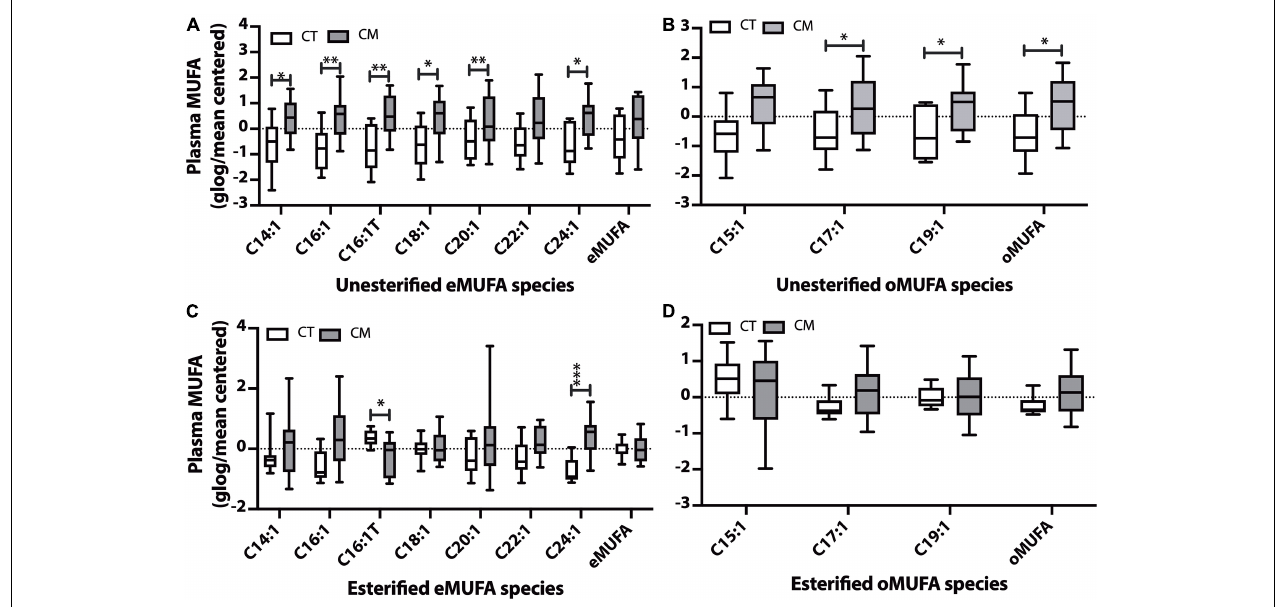
FIGURE 3 | Monounsaturated fatty acid (MUFA) changes in plasma of CT versus CM. We quantified MUFAs in plasma and plotted the normalized (glog/mean-centered) levels for unesterified even chain MUFAs (eMUFA) (A) , unesterified odd chain MUFAs (oMUFAs) (B) , esterified eMUFAs (C) , and esterified oMUFAs (D) . Multiple unpaired t -tests with correction for multiple comparisons (False Discovery Rate, FDR) using the two-state step-up method (Benjamini, Krieger, and Yekutieli) were used to compare MUFA levels in CT versus CM. One ( ∗ ), two ( ∗∗ ), or three asterisks ( ∗∗∗ ) denote adjusted p ( q ) < 0.05, q < 0.01, and q < 0.005,